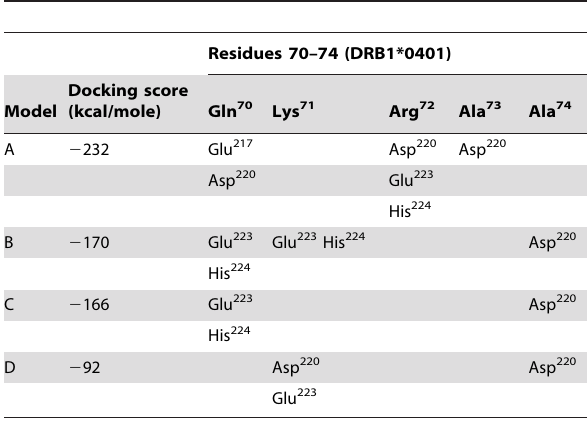
Table 1. Docking models: Interactions between SE and CRT residues.